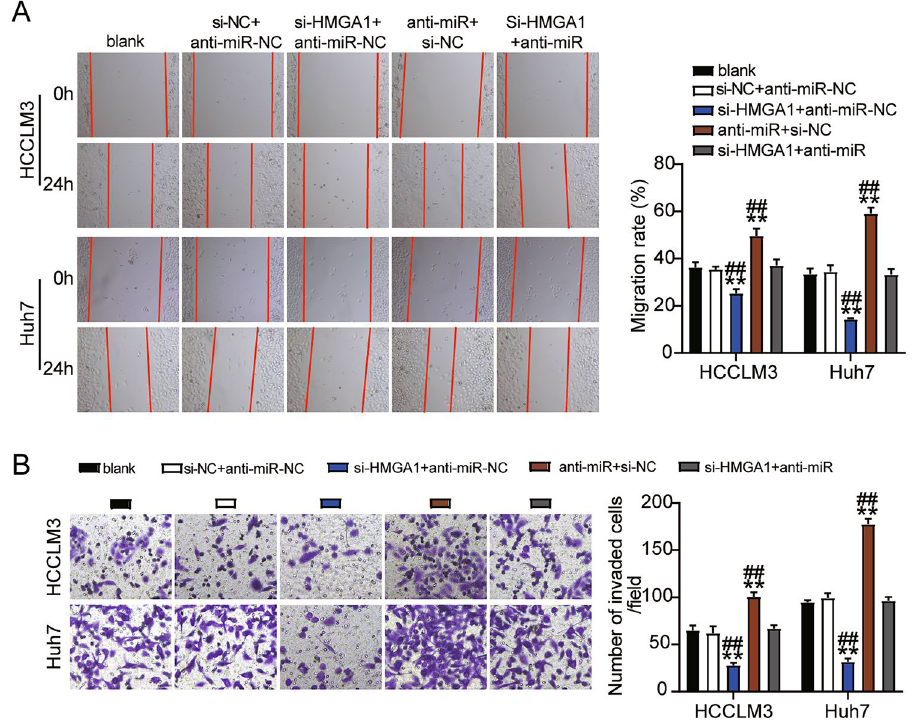
Figure 10. MiR-142-3p suppressed the migration and invasion in LIHC by repressing HMGA1. ( A ) Cell migration ability detection by wound healing assay. ( B ) the cell invasion detection using transwell assay. ## P < 0.001 compared with si-HMGA1 + anti-miR; **P < 0.001 compared with blank. anti-miR: miR-142-3p inhibitor; Si-HMGA1 + anti-miR: SiRNA-HMGA1 + miR-142-3p inhibitor, blank: blank control, NC: negative control; Si-HMGA: